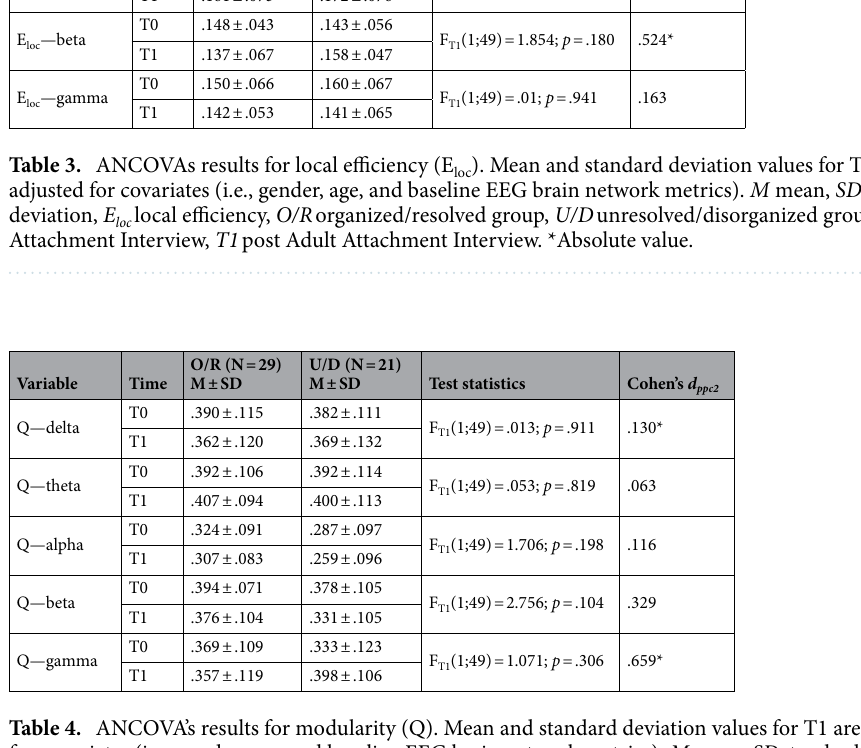
Table 4. ANCOVA’s results for modularity (Q). Mean and standard deviation values for T1 are not adjusted for covariates (i.e., gender, age, and baseline EEG brain network metrics). M mean, SD standard deviation, Q maximized modularity, O/R organized/resolved group, U/D unresolved/disorganized group, T0 pre Adult Attachment Interview, T1 post Adult Attachment Interview. *Absolute value.